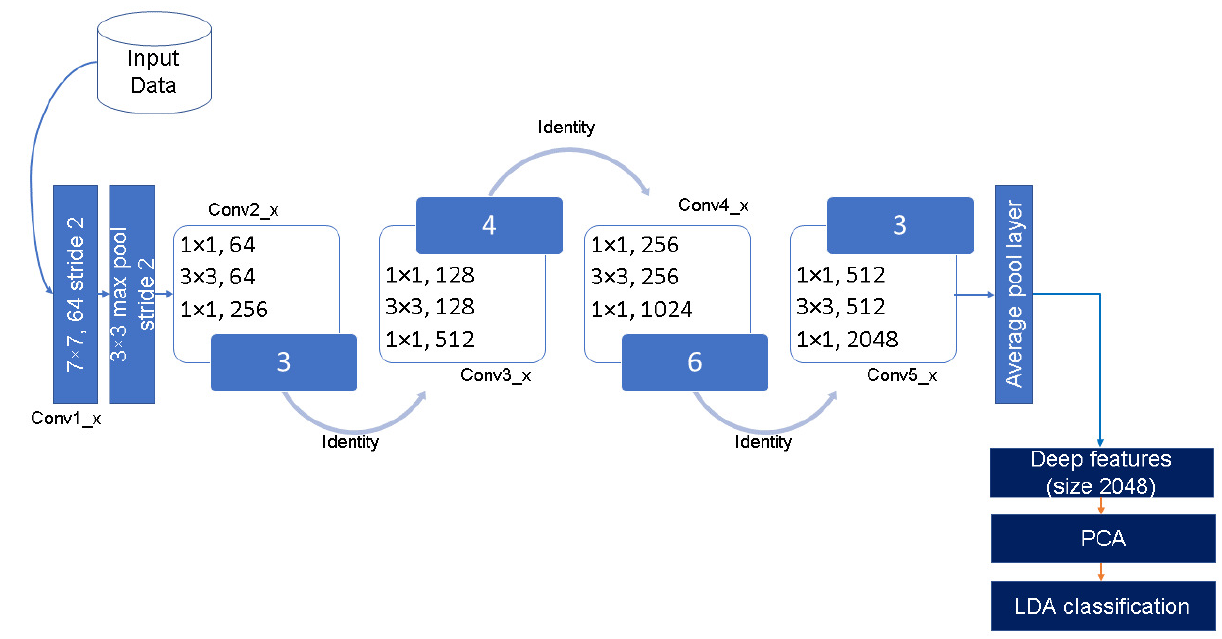
Figure 4. Modified ResNet50 architecture for Deep feature